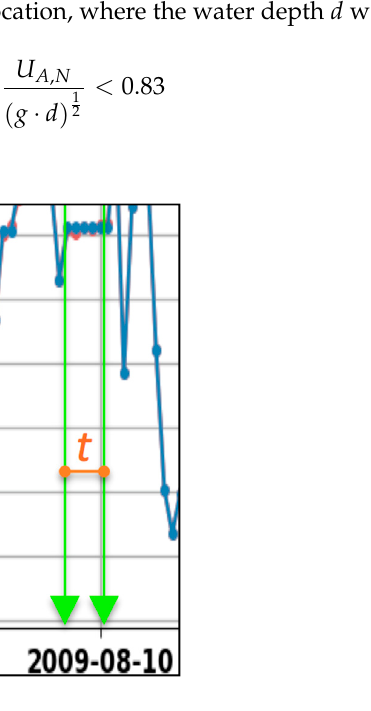
Figure 6. Determination of the duration of the steady wind generating the waves (zoom of Figure 5).